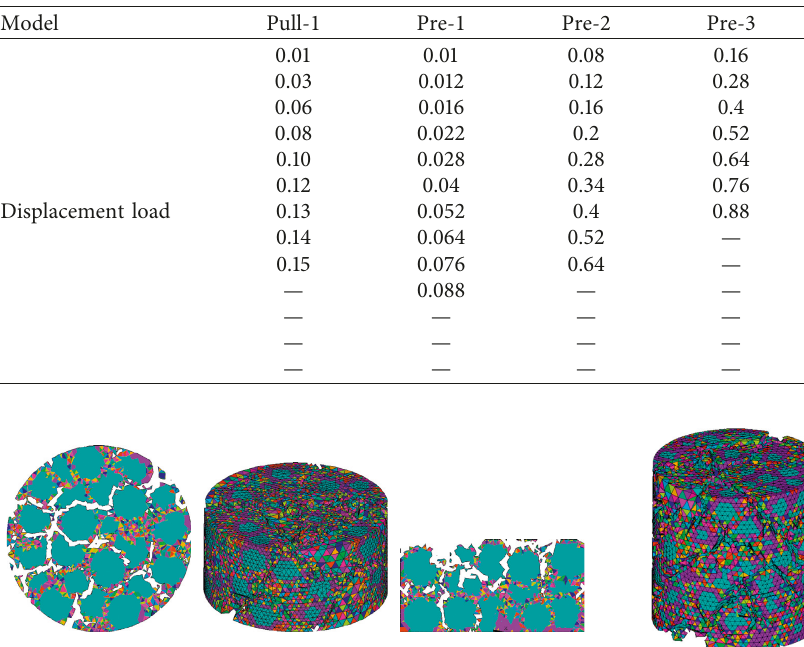
Table 4: Displacement control loading step.